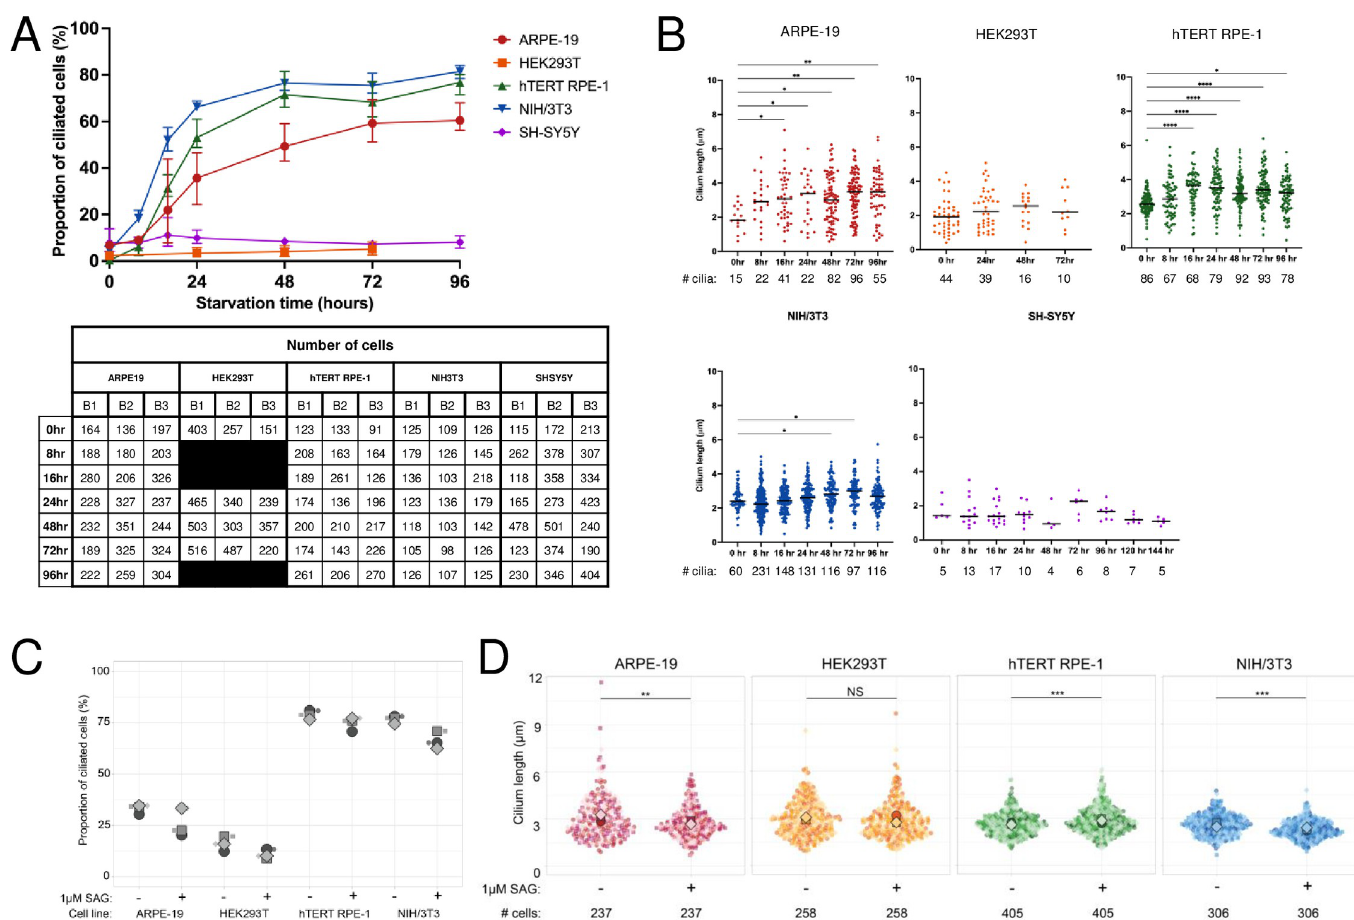
Fig 1. Ciliation time course and cilia length for immortal cell lines. A) Proportion of ciliated cells at 0, 8, 16, 24, 48, 72, and 96 hours post serum starvation. We performed three replicates for each time point, with error bars denoting the range for each time point across three batches. The numbers of cells counted at each time point and in each batch are listed in the table below the graph. B1 = batch 1, B2 = batch 2, and B3 = batch 3. B) Cilium length across time points. Black bars in each column represent median length. Significant p -values are denoted as follows: 0.01 to 0.05 ( � ), 0.001 to 0.01 ( �� ), and < 0.001 ( ��� ). No � ’s are shown for differences that are not statistically significant. C) Proportion of ciliated cells without and with stimulation. Each symbol represents the proportion of ciliated cells in one batch. No differences between untreated and treated cells within each cell line were statistically significant using the Mann-Whitney test. D) Cilium length without stimulation and with stimulation. Large symbols = median cilium length within a batch. Small symbols = cilium length of one cilium. One coverslip was imaged for each cell line and time point. The total number of cells counted across three batches are listed below each column of the graphs.